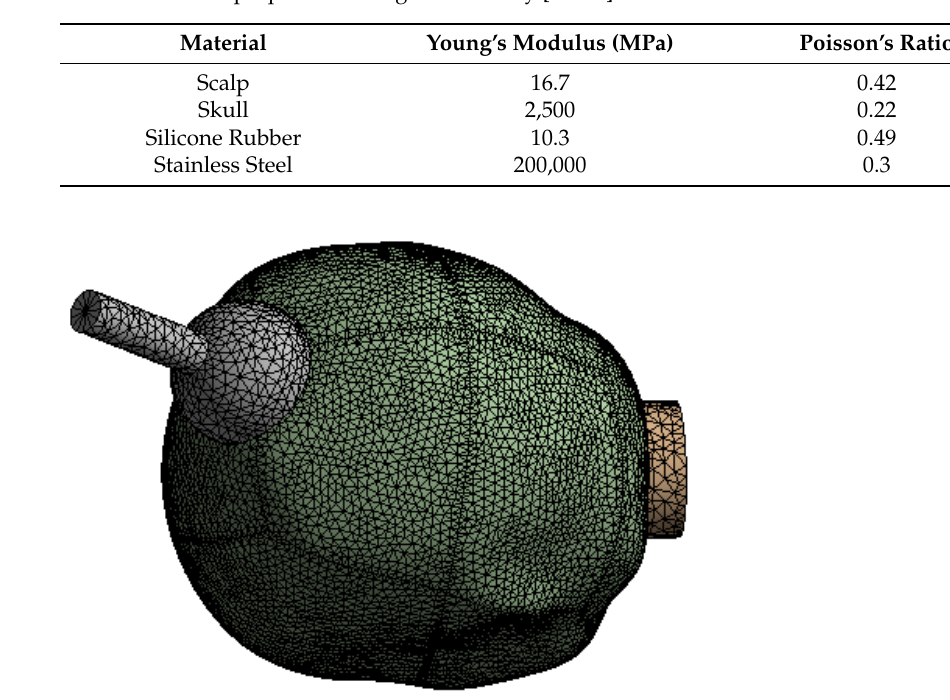
Table 1. Material properties setting in this study [15–17].